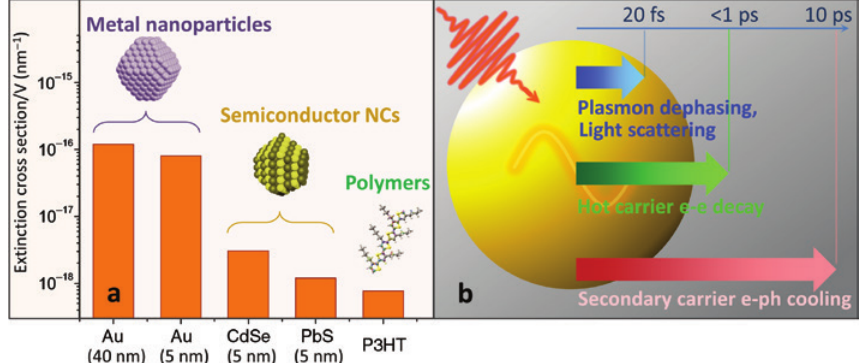
Figure 1: The excitation and decay of localized plasmons in metal nanoparticles. (A) Extinction cross-sections of common nanoscale sensitizers divided by the NP volume. The comparison highlights superior light-harvesting characteristics of metal NPs relative to semiconductor QDs and organic polymers (P3HT) [3–8]. Adapted with permission from Ref. [9]. Copyright 2014 American Chemical Society. (B) Timescale of the surface plasmon evolution in noble metal NPs, including stages of plasmon